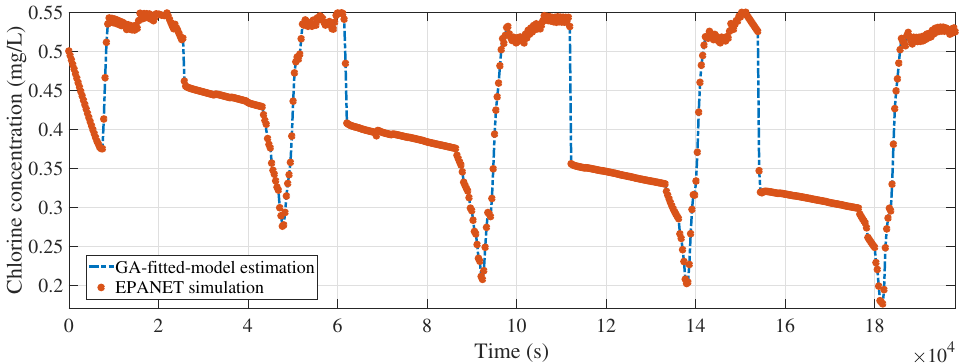
Figure 10. Calibrated model fitting for node 25 (rmse = 4.0421 × 10 − 4